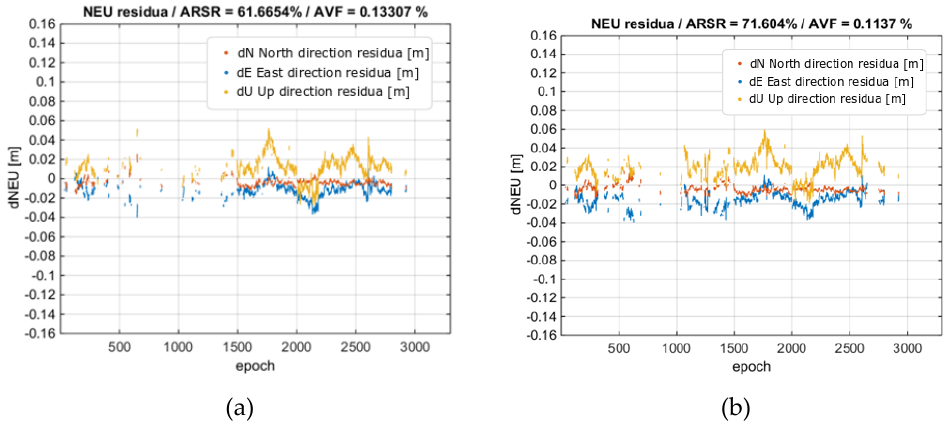
Figure 14. Rover position residua vs. the reference solution from processing MULTI3 solution. ( a ) No ionospheric corrections; ( b ) With ionospheric corrections. Horizontal residuals are in red and blue, and height residuals are in yellow.